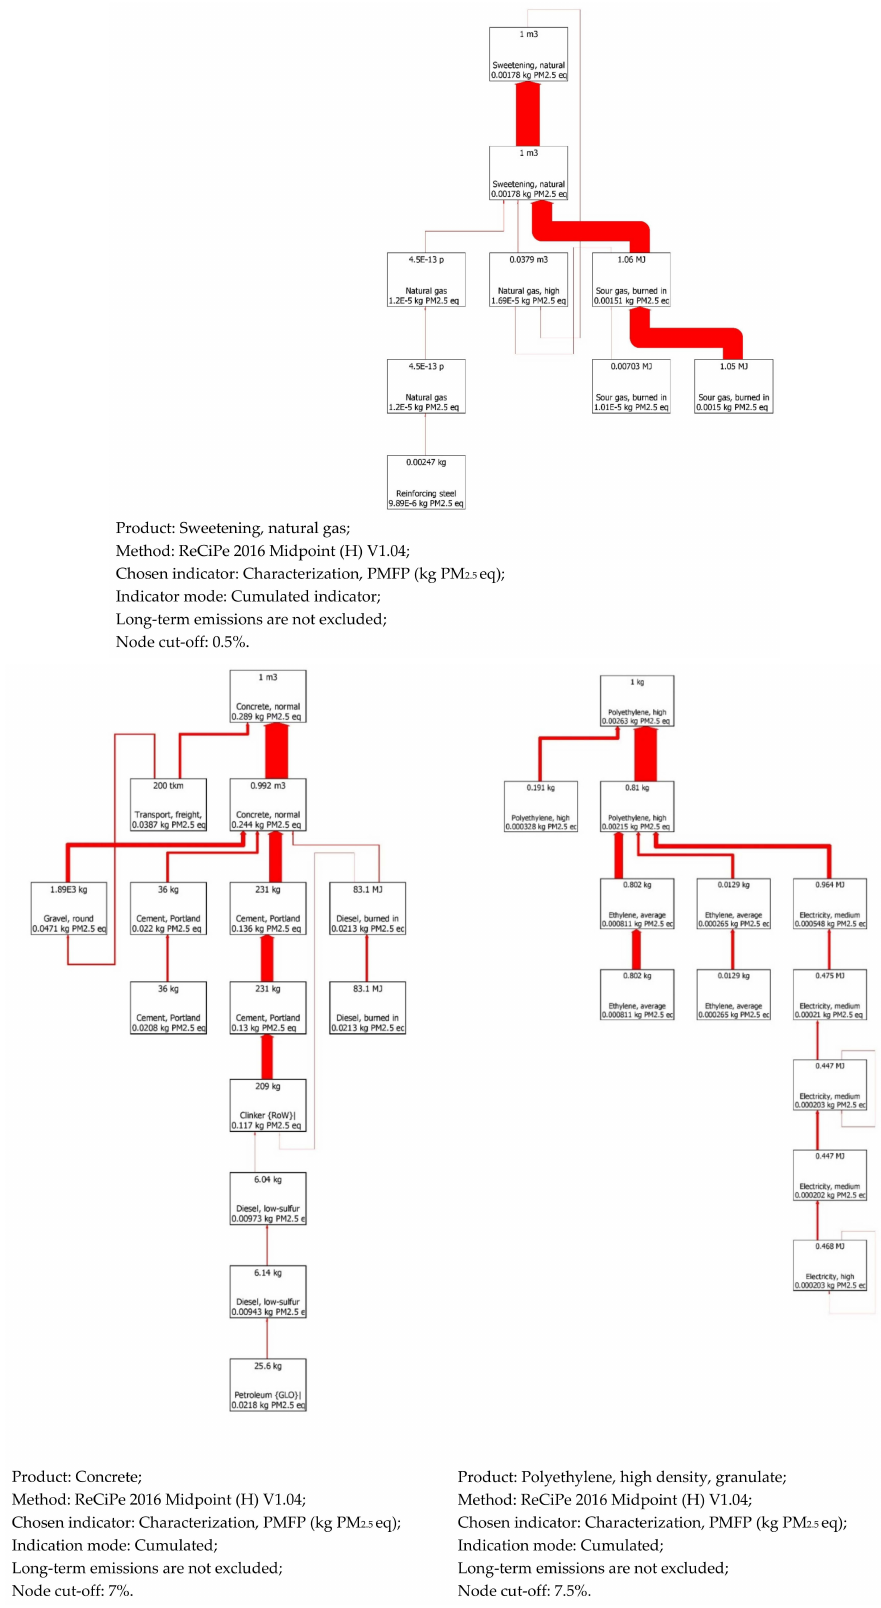
Figure A1. Structural data inventory flows used in the Ecoinvent database in for the PMFP in (kg PM 2.5